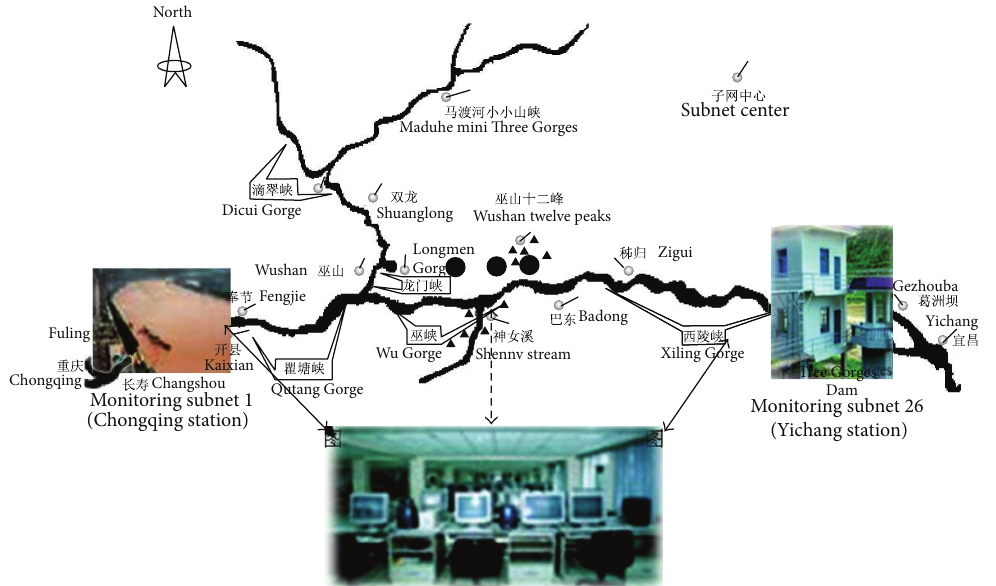
Figure 1: Distribution of the Three Gorges Reservoir and structure model of WSN water quality monitoring system.